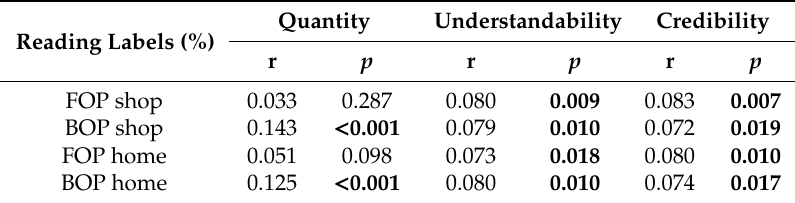
Table 11. Pearson coe ffi cients of reading food labels with the evaluation of the quantity, understandability, and credibility of selected information on food packaging.